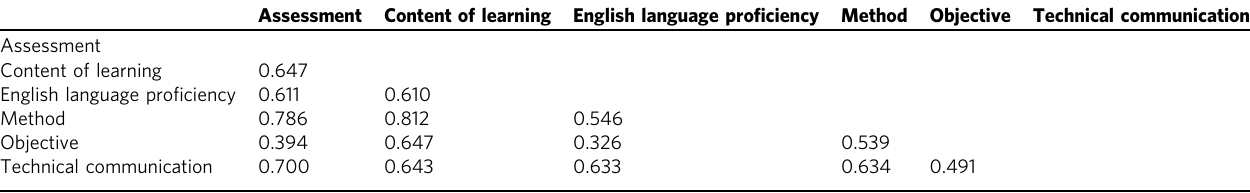
Table 12 Discriminant validity result based on the HTMT analysis for the HOCs.